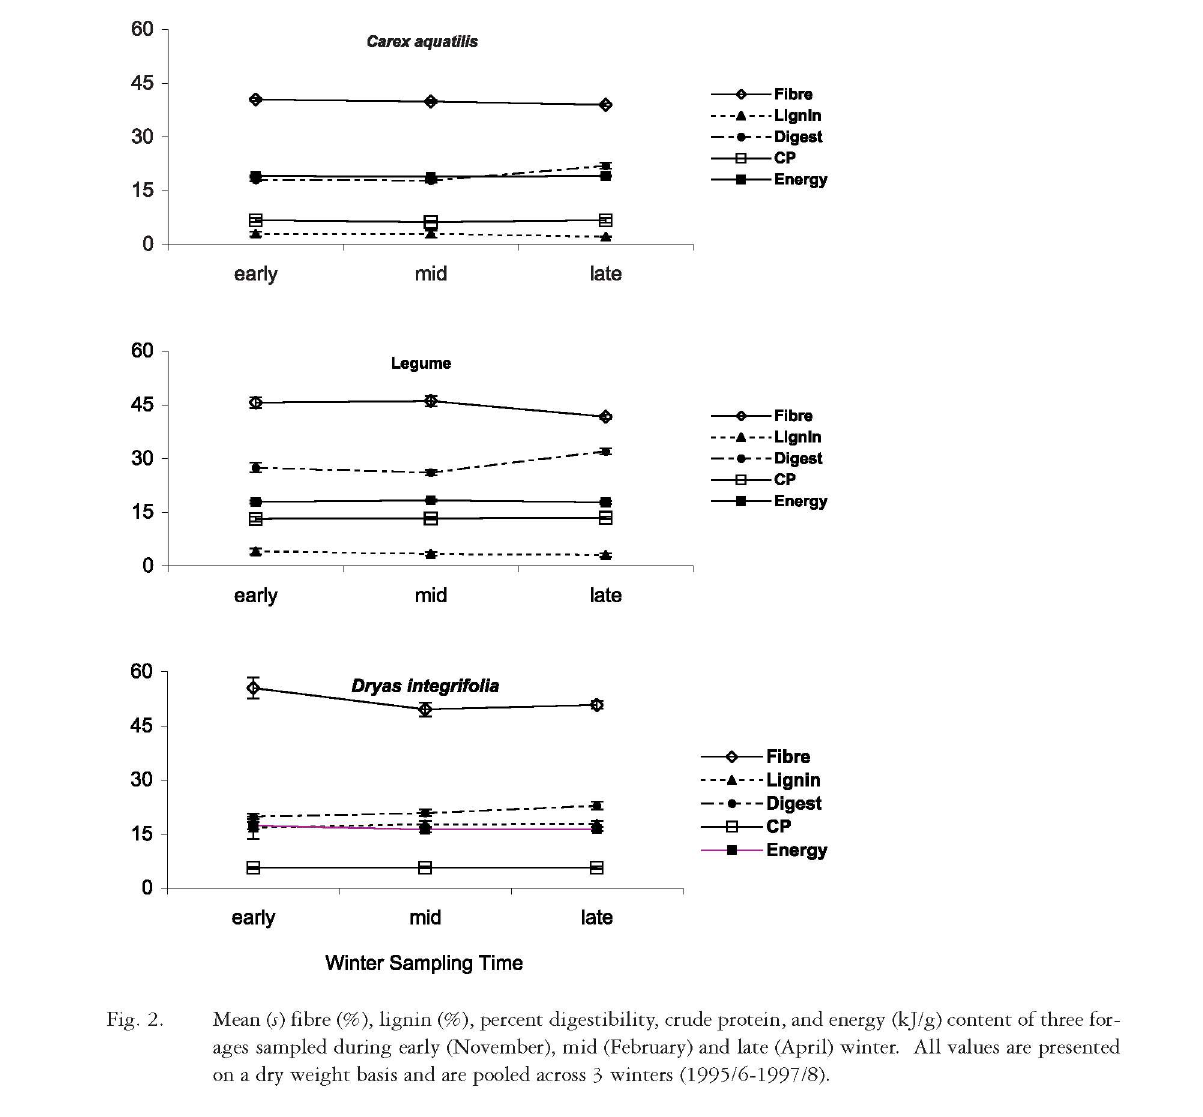
early mid Winter Sampling Time Fig. 2. Mean (s) fibre (%), lignin (%), percent digestibility, crude protein, and energy (kJ/g) content of three for¬ ages sampled during early (November), mid (February) and late (April) winter. All values are